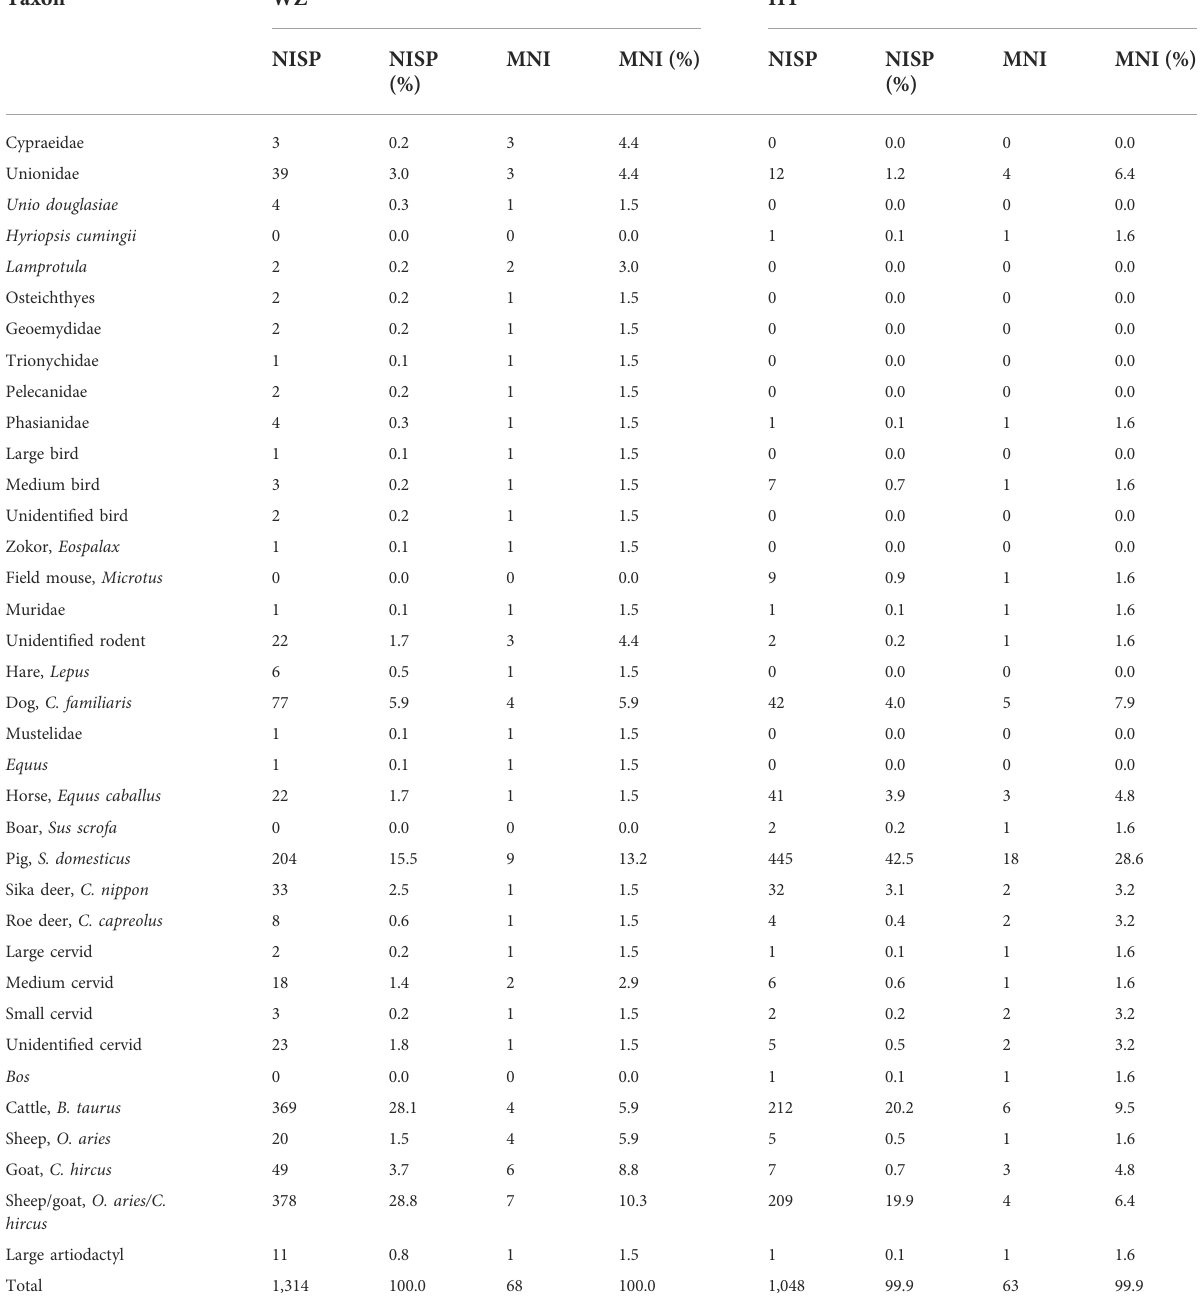
TABLE 2 NISP and MNI of animal remains from the WZ and HT contexts at